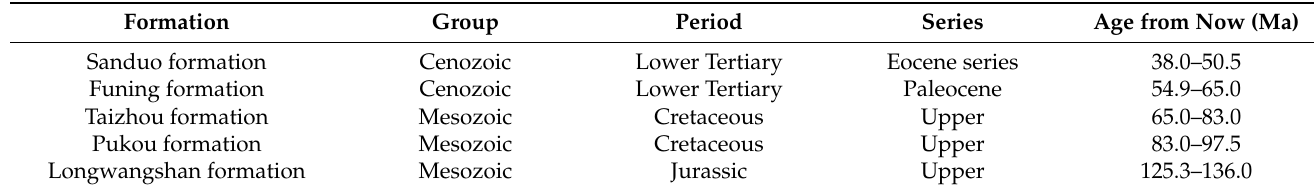
Table 1. Detailed stratigraphic information.